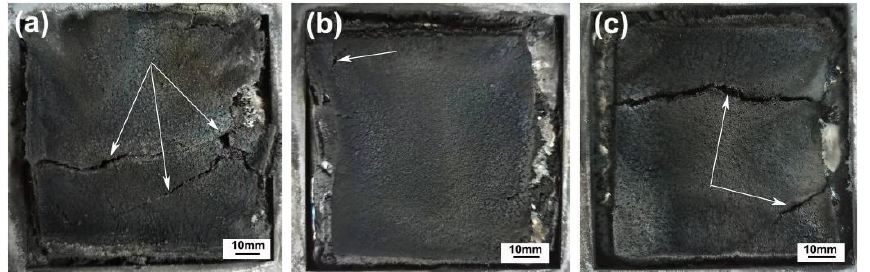
Figure 3. Digital photographs of charred residue of PP/SF composites after cone calorimeter test: ( a ) (PP/IFR)/SF; ( b ) (PP/SF)/IFR; ( c ) PP/IFR/SF.